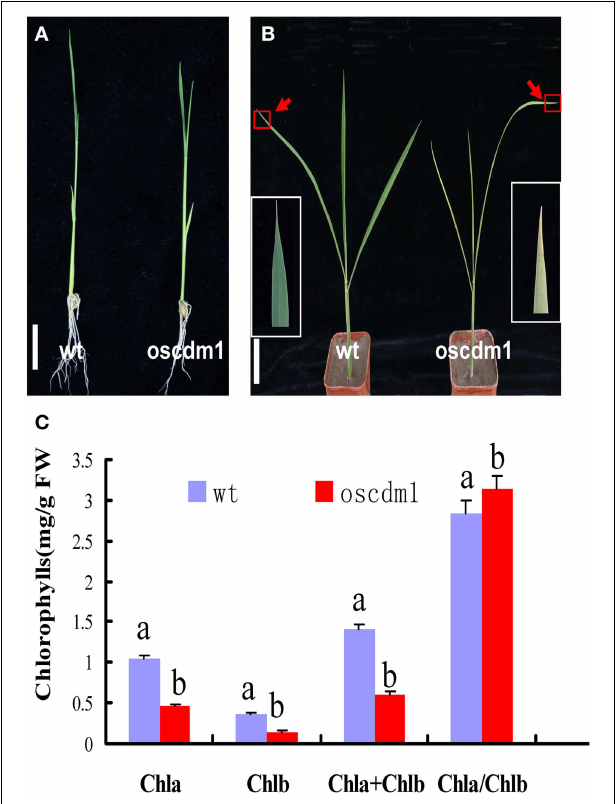
FIGURE 2 | Phenotype comparison of oscdm1 and wild-type plants. (A) Phenotypes of 10-day-old wild-type and mutant seedlings (bar = 1cm). (B) Phenotypes of 1-month-old wild-type and mutant seedlings (bar = 1cm). Red boxes denote the tips of the mutant and wild-type leaves. The insets show magnified views of the areas in the red boxes. (C) Measurement of the chlorophyll content in the leaves of 1-month-old wild-type and oscdm1 mutant plants. The data are the means ± standard deviation (SD). Bars represent the SDs ( n = 5 ). Data were compared by one-way analysis of variance and Duncan’s multiple range test. Different letters (a – b) indicate significant differences (P, 0.05) between lines. Chla, chlorophyll a ; Chlb, chlorophyll b .